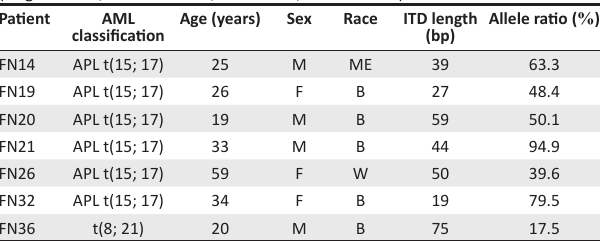
Table 2 : Acute myeloid leukaemia patients positive for the FLT3 -ITD mutation (August 2020, Bloemfontein, Free State, South Africa). Patient